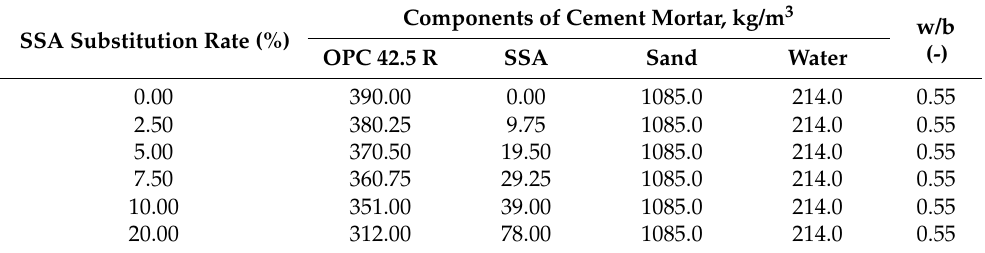
Table 1. Composition of the cement mortars without and with sewage sludge ash (SSA). SSA Substitution Rate